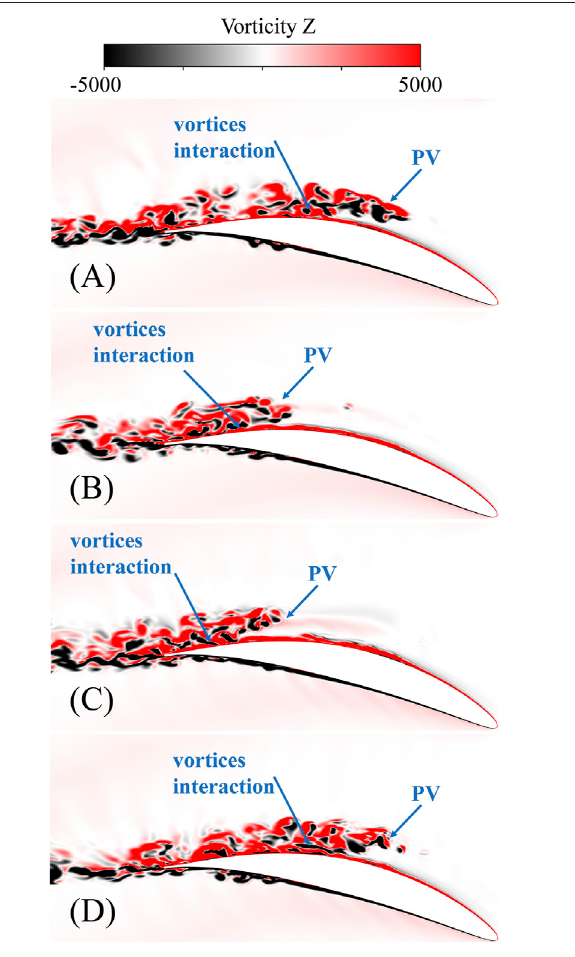
FIGURE 12 | Instantaneous vorticity contour map in spanwise at plane 5 mm away from the endwall. (A) Baseline; (B) CS (C) PS, t = T + 1/2 τ ; (D) PS, t = T + τ